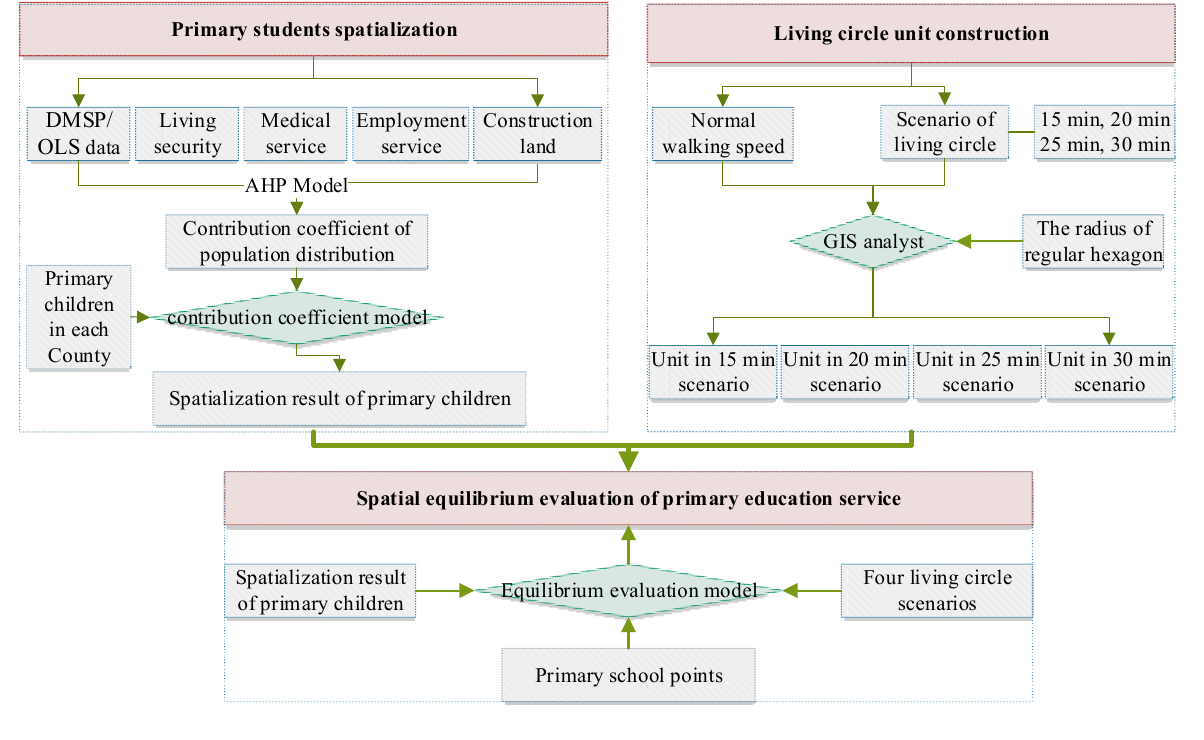
Figure 2. Methods flowchart.